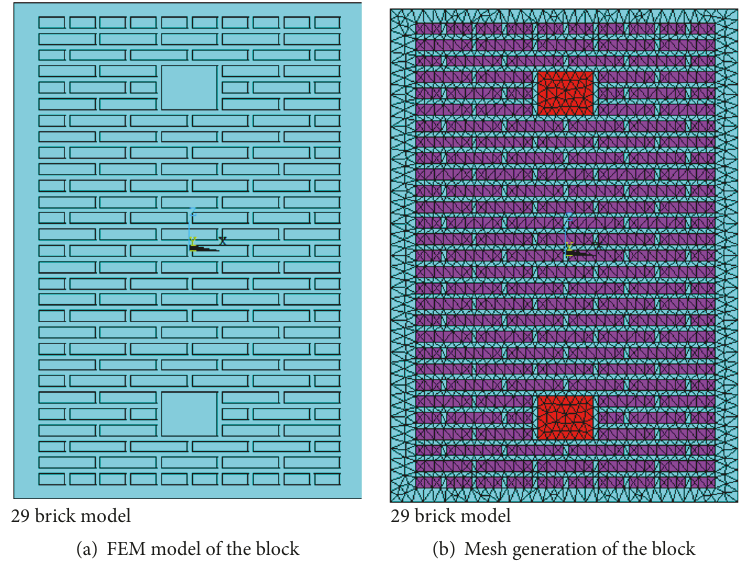
Figure 9: FEM model of the hollow shale